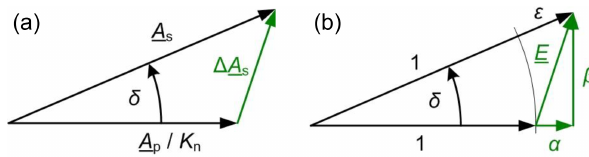
Figure 1. (a) Phasor diagram of an instrument transformer with converted primary quantity A p /K n , secondary quantity A s , and phase displacement δ . The complex difference (cid:49)A s is shown in green. (b) Phasor diagram following from the figure on the left by normalization with A p /K n , with the ratio error ε and the complex measurement error E with the associated real part α and imaginary part β (green).